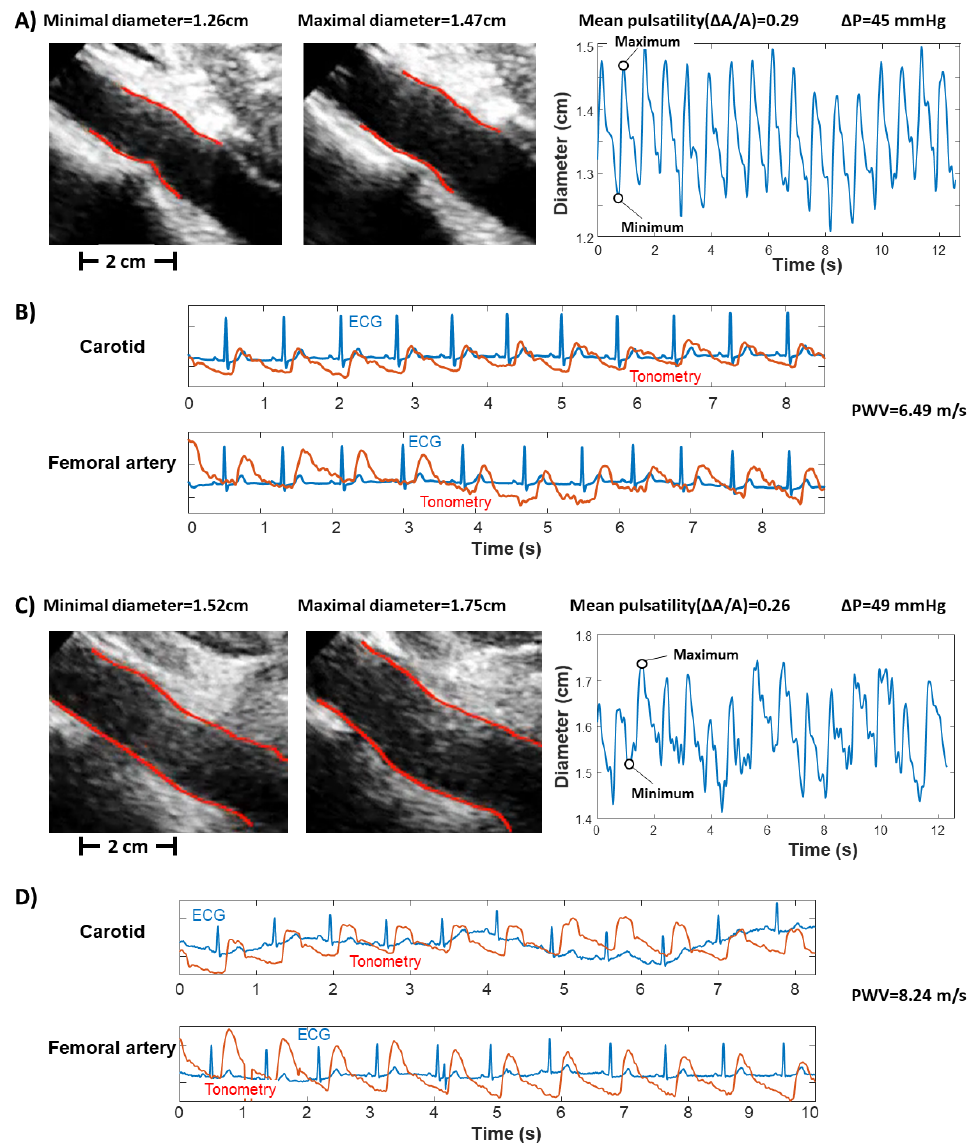
Figure 1. Experimental data from two subjects with different carotid–femoral pulse wave velocities (cf-PWV): ( A , B ) subject with medium PWV; ( C , D ) subject with high PWV. Ultrasound scans are considered in ( A , C ), showing two frames corresponding to local minimum and maximum average diameter (left) and the diameter over time (right). The indication of average pulsatility ∆ A / A and pressure variation ( ∆ P , obtained using PulsePen in these cases) are provided. Tonometry is shown in ( B , D ), for both the carotid and femoral artery, with the measured cf-PWV